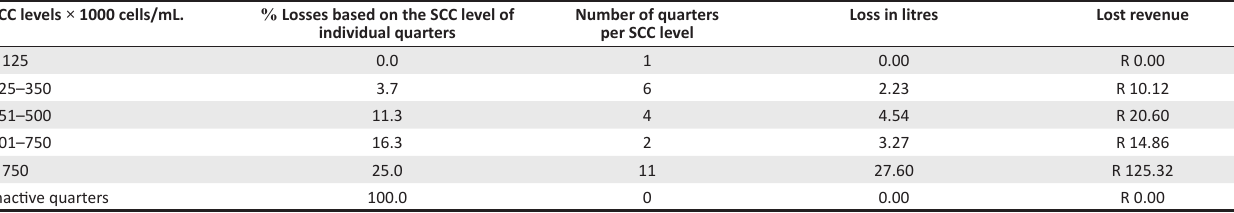
TABLE 6: Estimated milk production losses in a herd associated with quarters infected with Streptococcus agalactiae. SCC levels × 1000 cells/mL. % Losses based on the SCC level of individual quarters